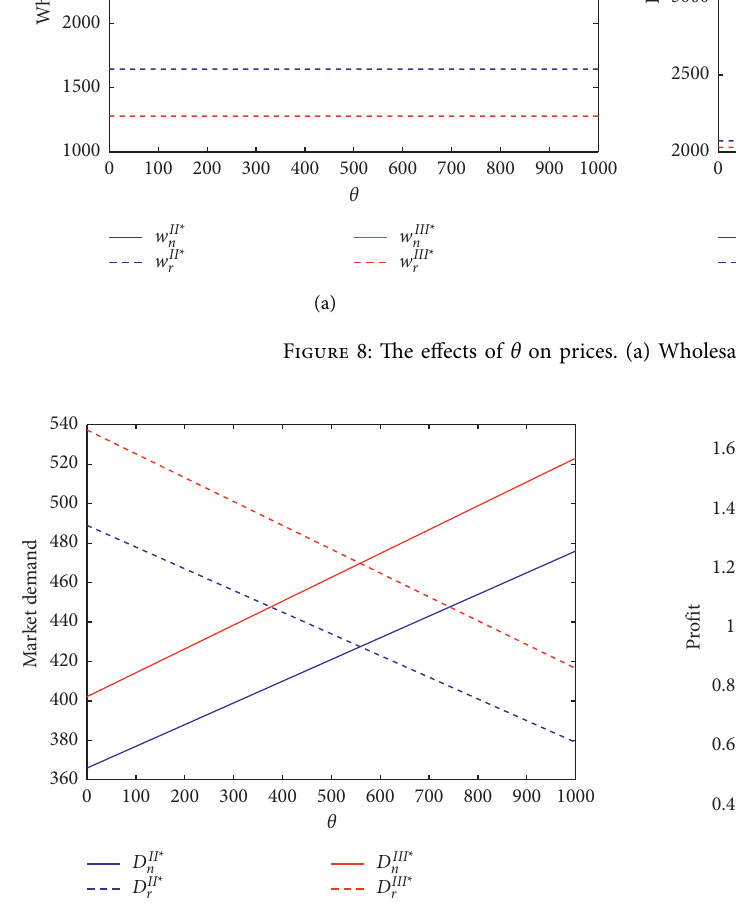
Figure 9: The effects of θ on market demands.